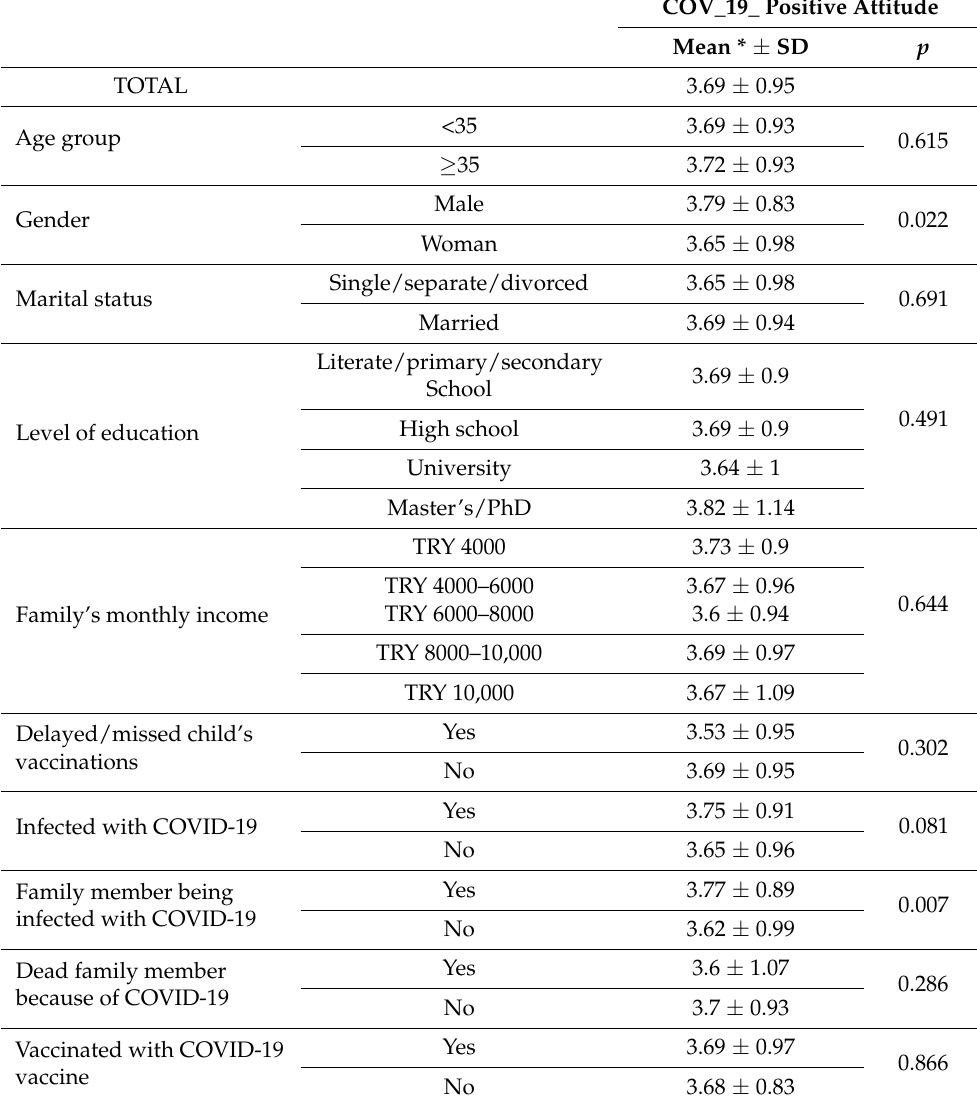
Table 3. Descriptive Statistics and Determination of the Factors that Affect Positive Attitudes Based on Demographic